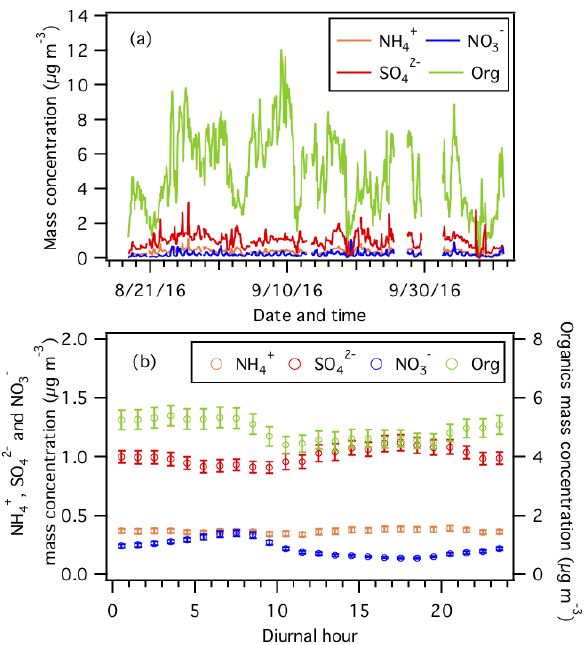
Figure 2. (a) Time series and (b) diurnal profiles of non-refractory PM 1 species measured by the AMS. Error bars shown in (b) are the standard errors. Dates and times displayed are local time.